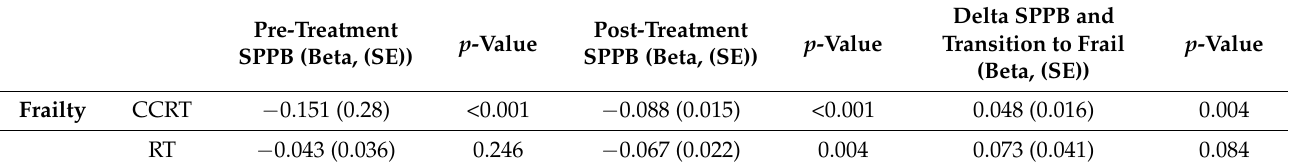
Table 6. Correlation between SBBP and frailty